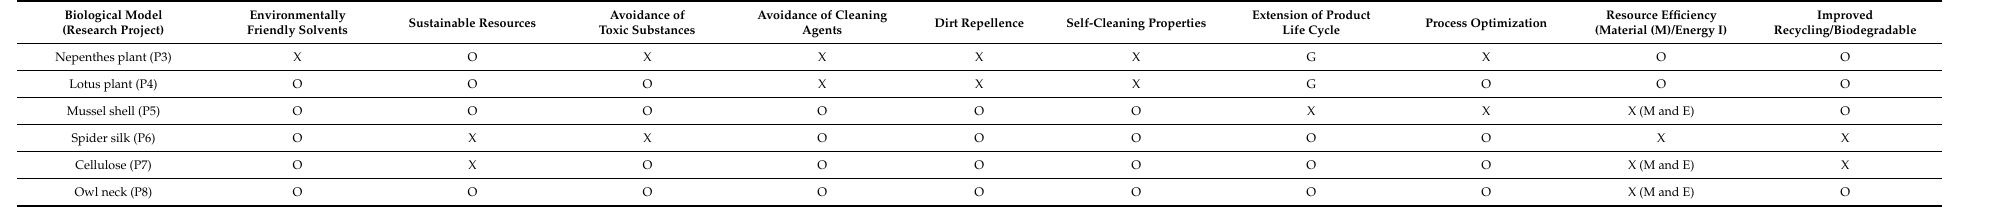
Table 3. Biological models and their sustainability strategies addressed in the respective research